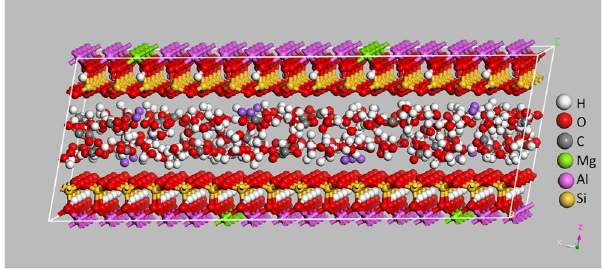
Figure 1. Snapshot of MD simulation of 64 CO 2 and 160 H 2 O molecules in MMT cell.